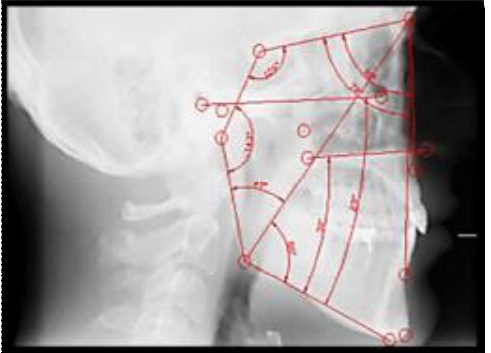
Figure 3: Angular Measurements Obtained from Cephalometric Radiography. Patients’ Preparation for Ultrasonographic Scanning: